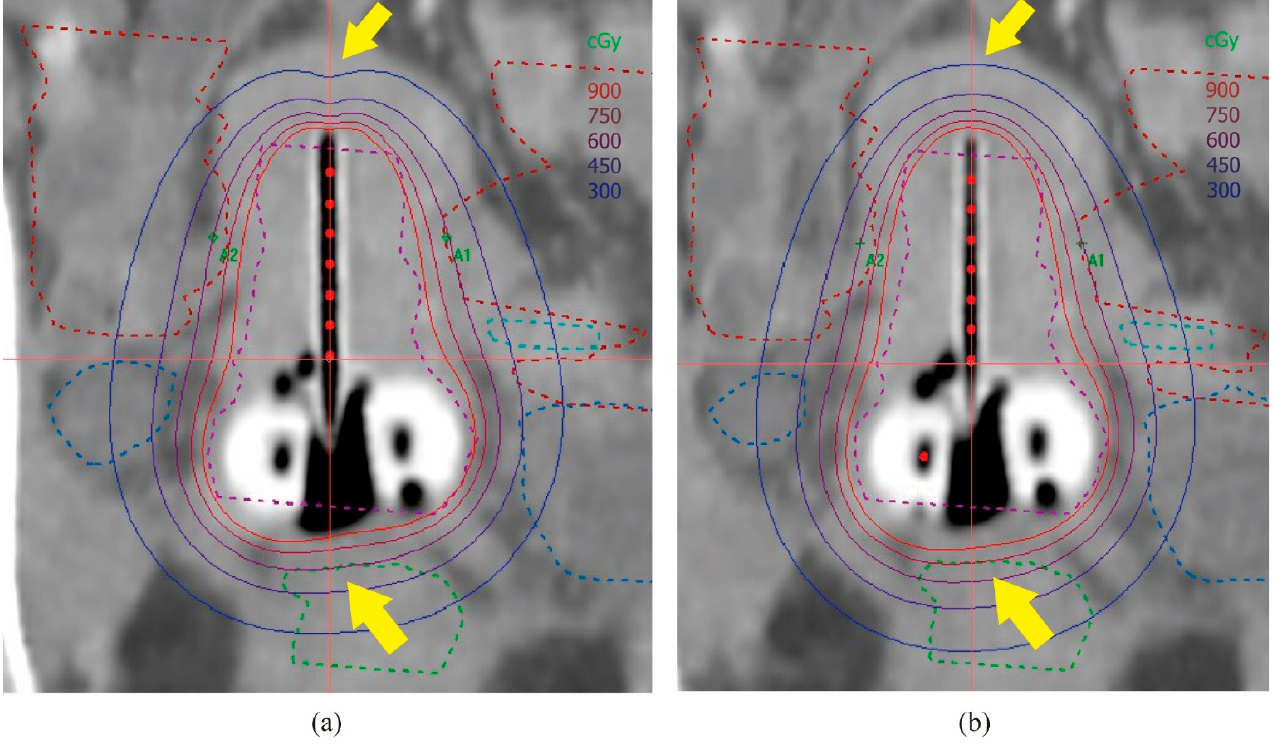
Figure 4. (2D HDR BT) Distribution of isodose lines in the transseptal canal’s coronal plane. ( a ) 192Ir; ( b ) 60Co. As indicated by the arrows, 60Co was more prominently distributed in the cephalocaudal direction and provided a higher dose in the rectum.